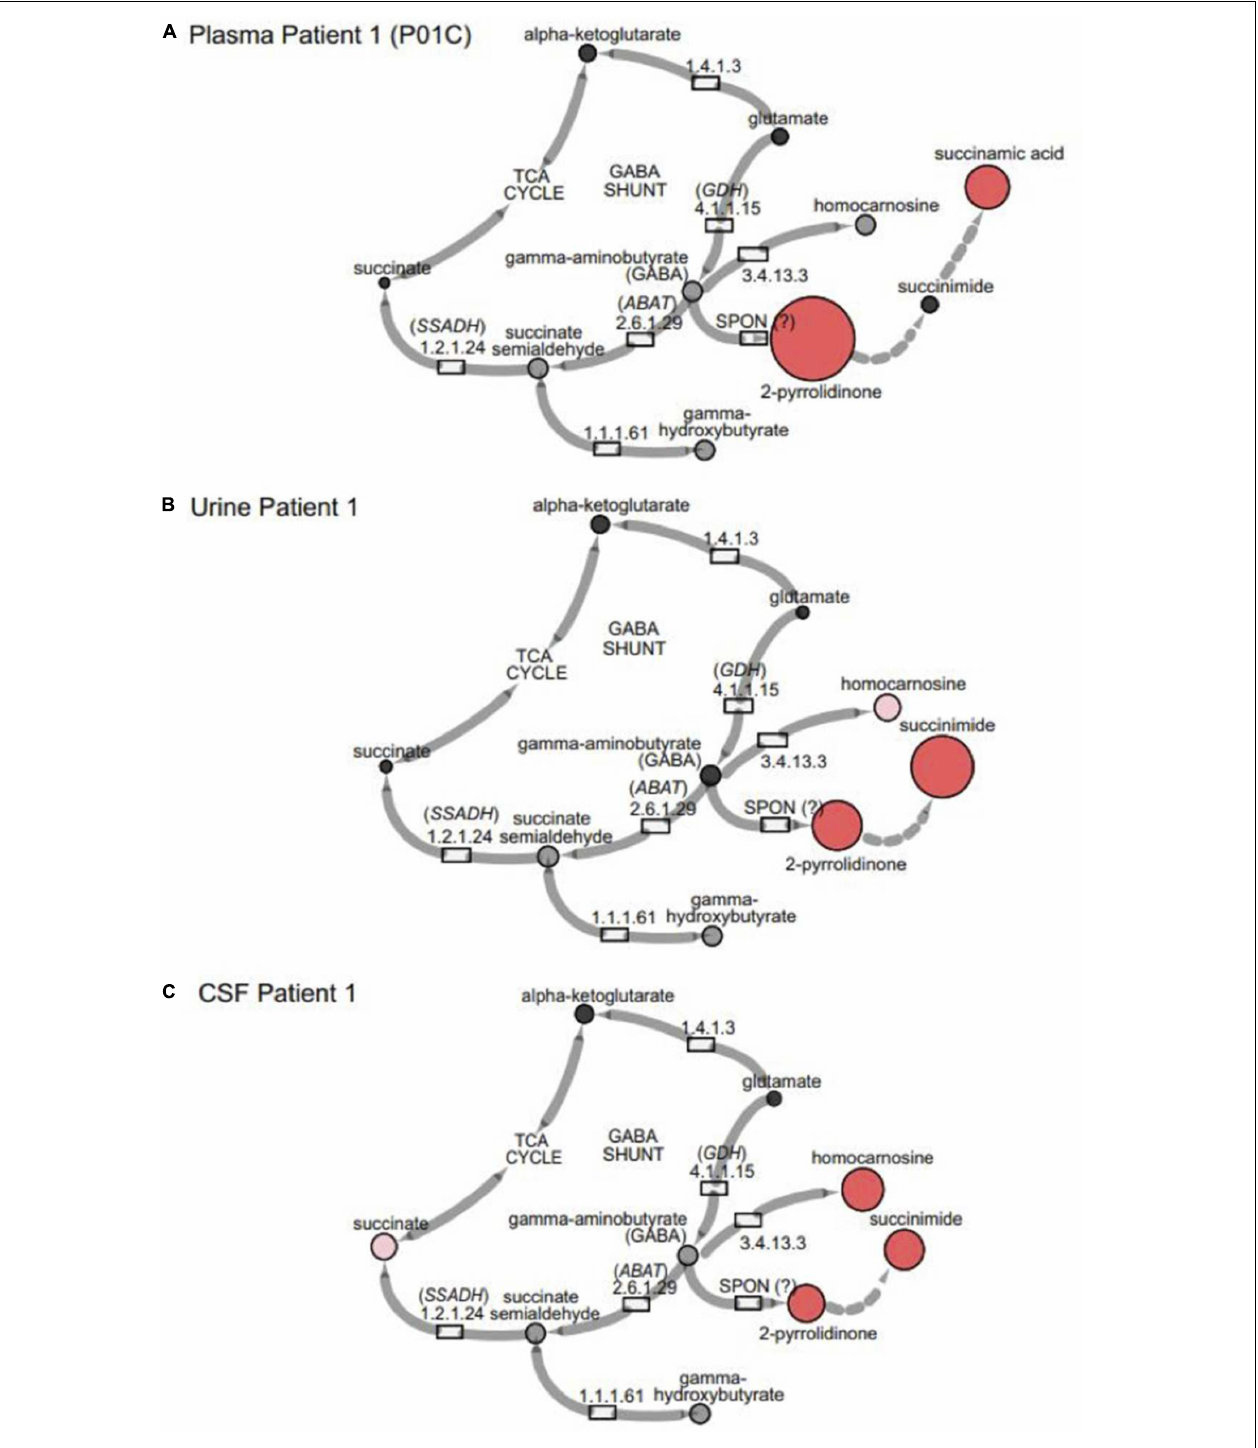
FIGURE 3 | GABA metabolites are altered in GABA-transaminase deficiency and in use of treatments affecting GABA metabolism. Representative pathway images are shown for GABA-transaminase deficiency Patient 1 in (A) EDTA Plasma, (B) Urine, and (C) CSF. Each image shows the relative accumulation of biochemicals (red circles) or trending increases (pink circles, 1.5 ≤ Z < 2). The size of each of the circles is representative of the Z -score for that biochemical. Black circles represent molecules with Z -scores between –1.5 and 1.5 (–1.5 < Z < 1.5) or detected rare molecules for which a Z -score could not be calculated. Gray circles represent biochemicals in the library but not detected in the samples using Cytoscape to delineate biochemical pathways (http://cytoscape.org) (Shannon et al., 2003). All enzymes in the pathway are denoted by their EC designations. GDH , glutamate dehydrogenase; SSADH , succinic semialdehyde dehydrogenase; ABAT , aminobutyrate aminotransferase; SPON,